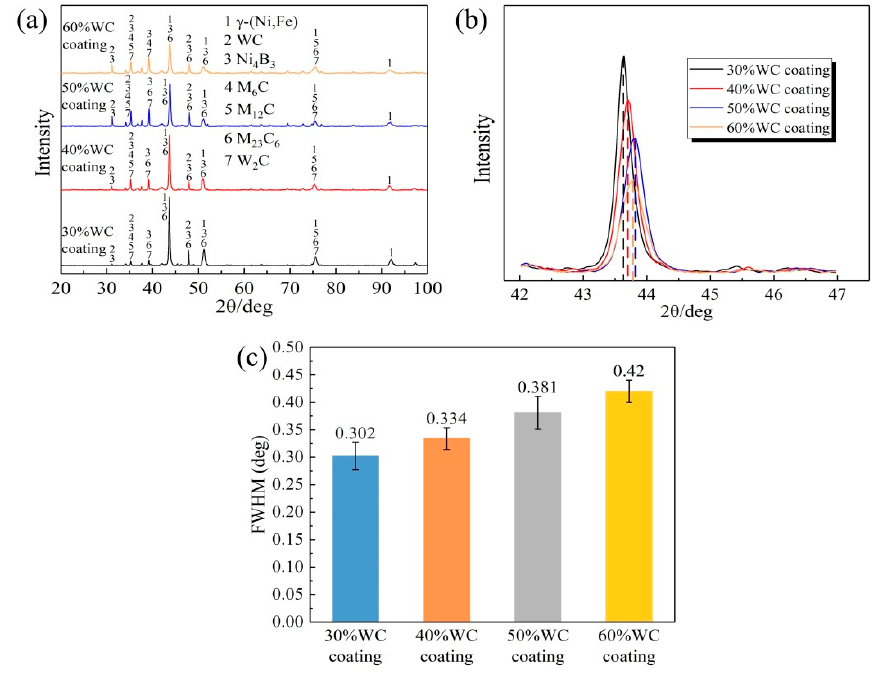
Figure 3. ( a ) XRD analysis of 30–60% WC coatings surfaces, ( b ) the offset of diffraction peak, and ( c ) the FWHM values of the four coatings.